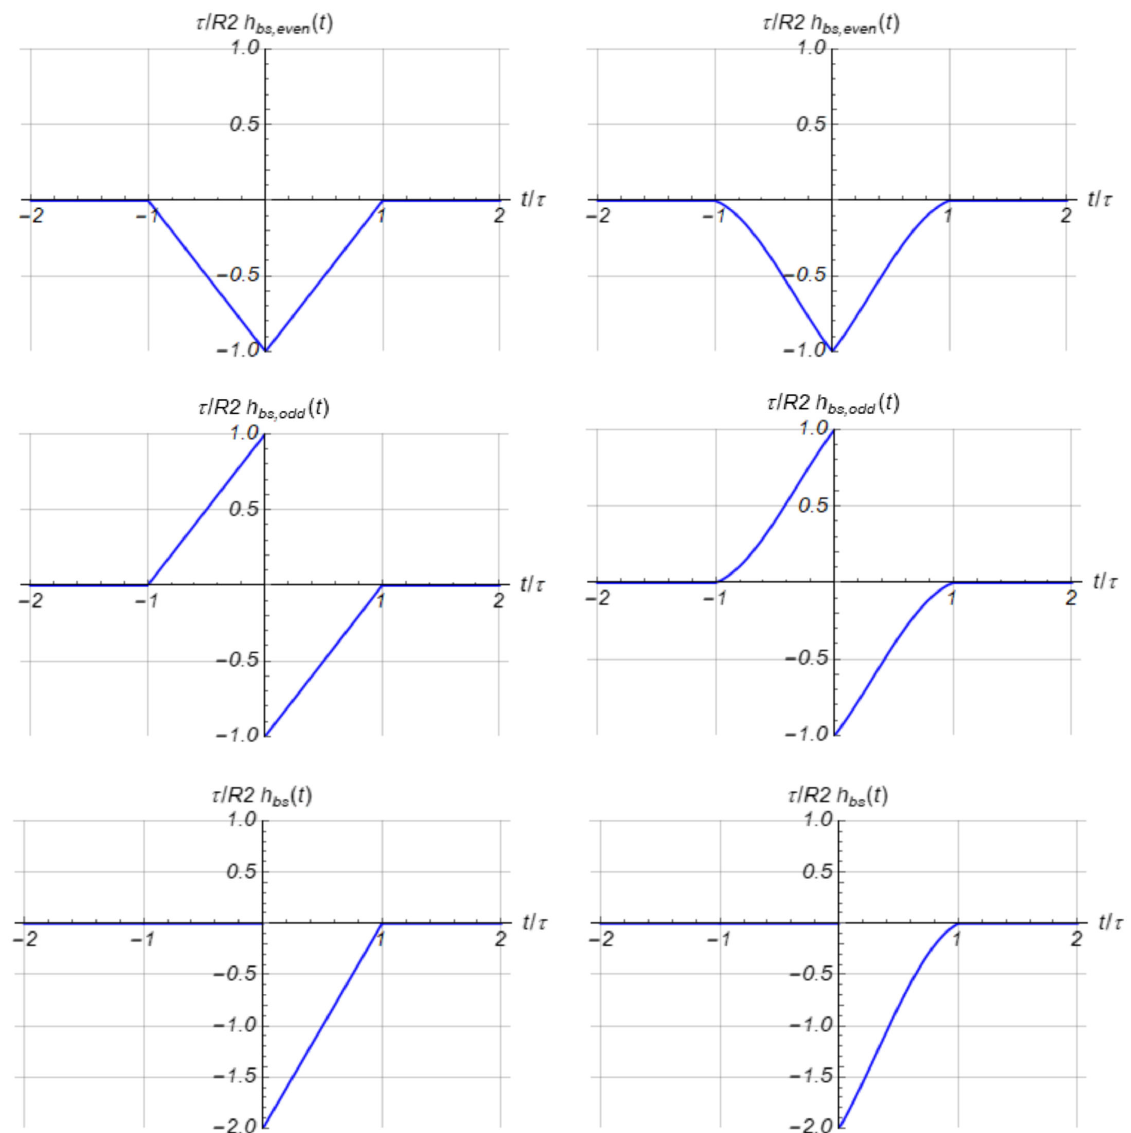
t Þ normalized. For Δ f 0 τ ¼ 0 (left) and Δ f 0 τ ¼ 0 . 2 (right). The top FIG. 27. Impulse response to beam current. Diagonal term h bs ð trace is the even-symmetric part, the middle trace shows the odd-symmetric and the bottom trace is the sum that is